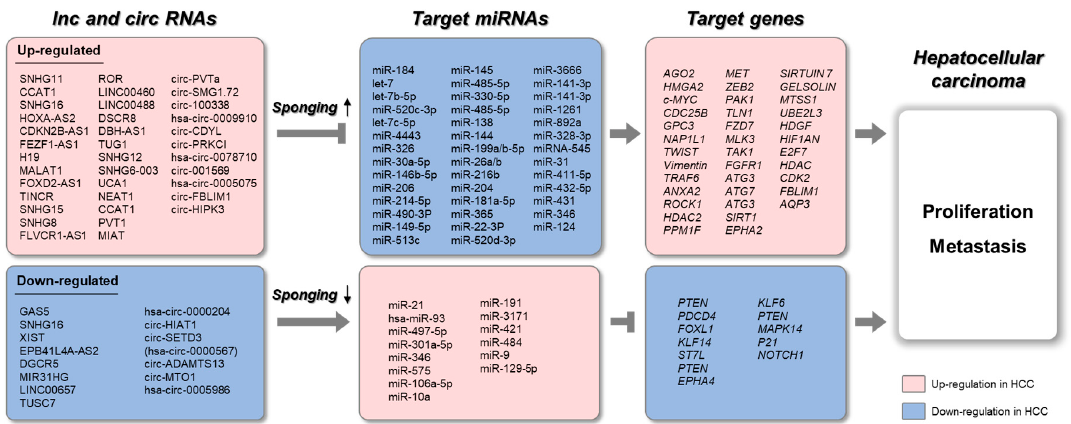
Figure 3. Schematic representation of lnc/circRNAs serving as ceRNAs in HCC. The upregulated long non-coding RNAs (lncRNAs) and circular RNAs (circRNAs) sponge target microRNAs (miRNAs), which results in increased expression of target genes. The downregulated lncRNAs and circRNAs sponge target miRNAs, which results in decreased expression of target genes.